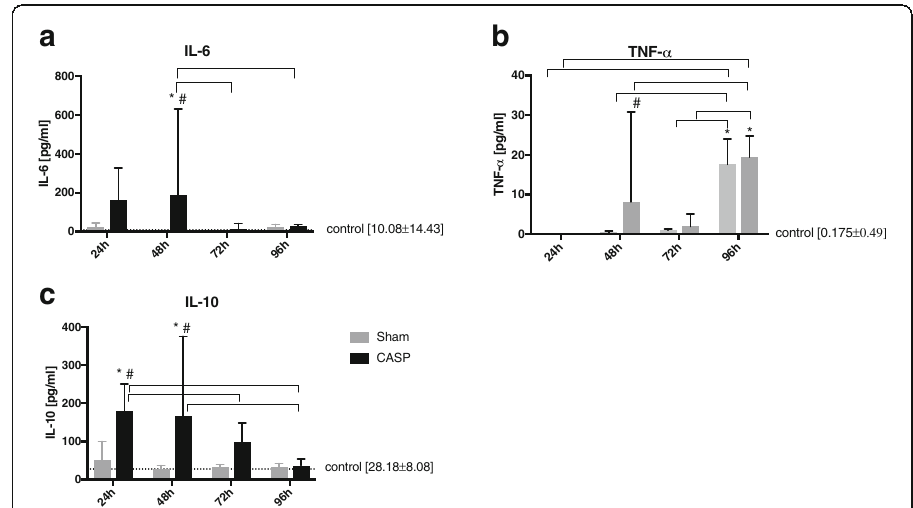
Fig. 2 Markers of inflammation change in a time-dependent manner in the course of abdominal infection. Plasma levels of IL-6 ( a ), TNF- α ( b ), and IL-10 ( c ) were analysed at 24, 48, 72, and 96 h post operation (sham operation, light grey bars; CASP, dark grey bars). Healthy, non-operated rats served as controls (straight horizontal dotted line). Data are shown as mean ± SD (controls n = 9, sham n = 12, CASP 24 h n = 11, other CASP groups n = 12, * p < 0.05 vs. controls, # p < 0.05 vs. sham, between